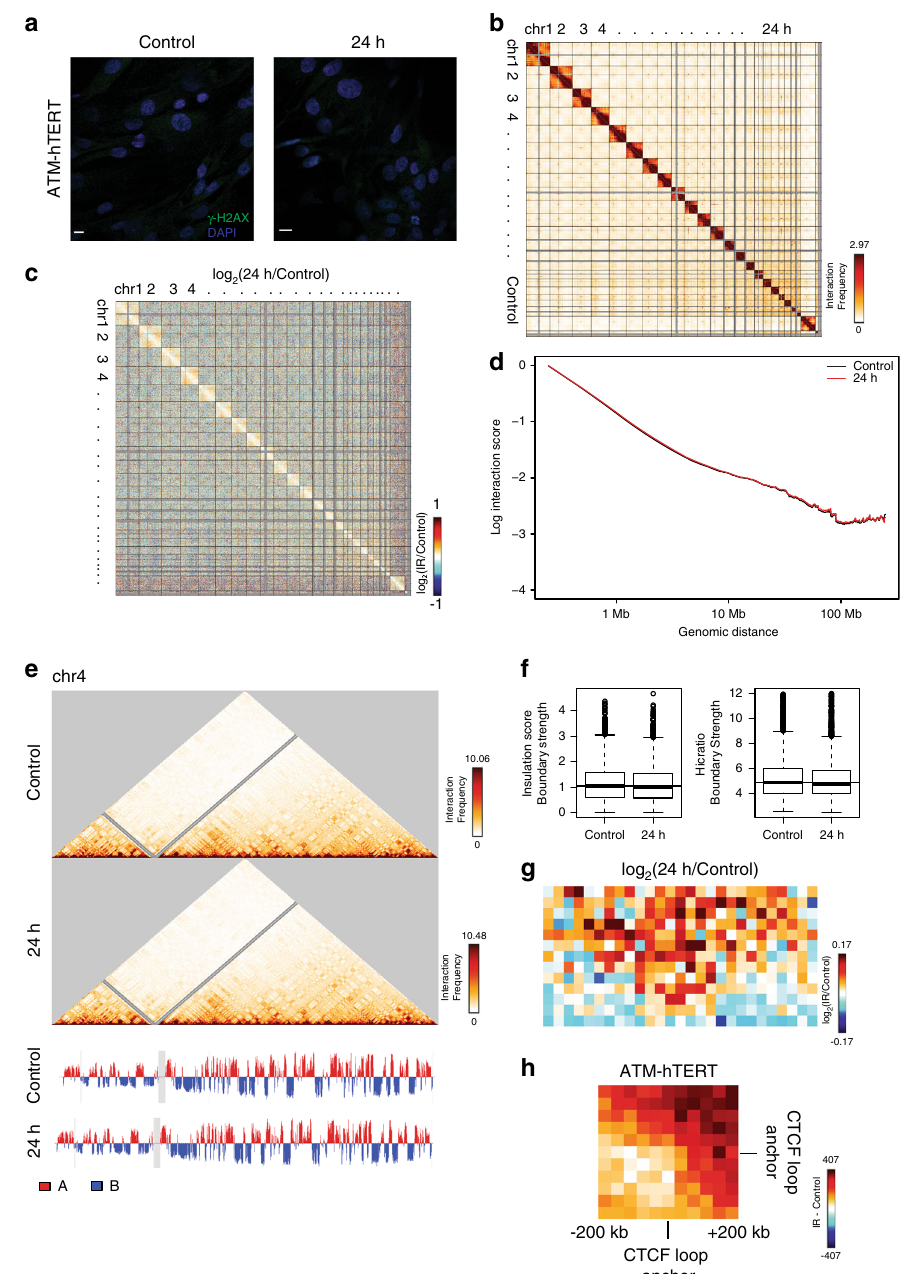
Fig. 5 ATM is necessary for 3D genome organization change after IR exposure. a ATM mutant cells stained with γ H2AX (green) and DAPI (blue) after before (Control) or after exposure to 5 Gy X-rays. Scale bar: 10 μ m. b Genome-wide contact heatmap of ATM mutant cells in nonirradiated (lower left) or 24 h after IR (upper right) in 2.5 Mb bins. c log2(24 h post-IR/Control) contact heatmap in 2.5 Mb bins. d Scaling plots showing average decay of contacts with distance across all chromosomes at a 250 kb bin size in ATM mutant cells for control and 24 h post-IR. e 250 kb bin size Hi-C interaction heatmaps for chromosome 4 in ATM mutant cells in control (Top) and 24 h post-IR (Bottom) show little difference in compartment as evidenced by little change to A (red) and B (blue) compartmentalization in the fi rst principle component (below heatmaps). f TAD boundary strength boxplots calculated using both the InsulationScore (Number of TAD boundaries (N) ATM-hTERT = 1311) and Hicratio (Number of TAD boundaries (N) ATM-hTERT = 1674) methods for ATM mutant cells. A one-tailed Wilcoxon signed rank test showed that the 24 h sample boundaries were not statistically increased compared to controls. Boxes represent the upper and lower quartiles with the center line as the median. Upper whiskers extend 1.5 × IQR beyond the upper quartile, and lower whiskers extend either 1.5 × IQR below the lower quartile or to the end of the dataset. g Contact maps were aggregated at TAD boundaries called by InsulationScore with strength greater than 1 and then these maps are compared by log2(24 h post-IR/Control). h Subtraction of 24 h minus Control aggregate CTCF-anchored loop contact maps in these ATM mutant